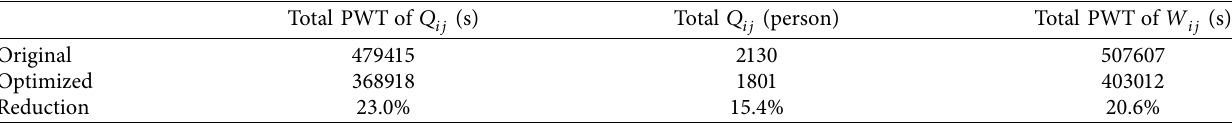
Table 9: Changes of PWT between different passenger